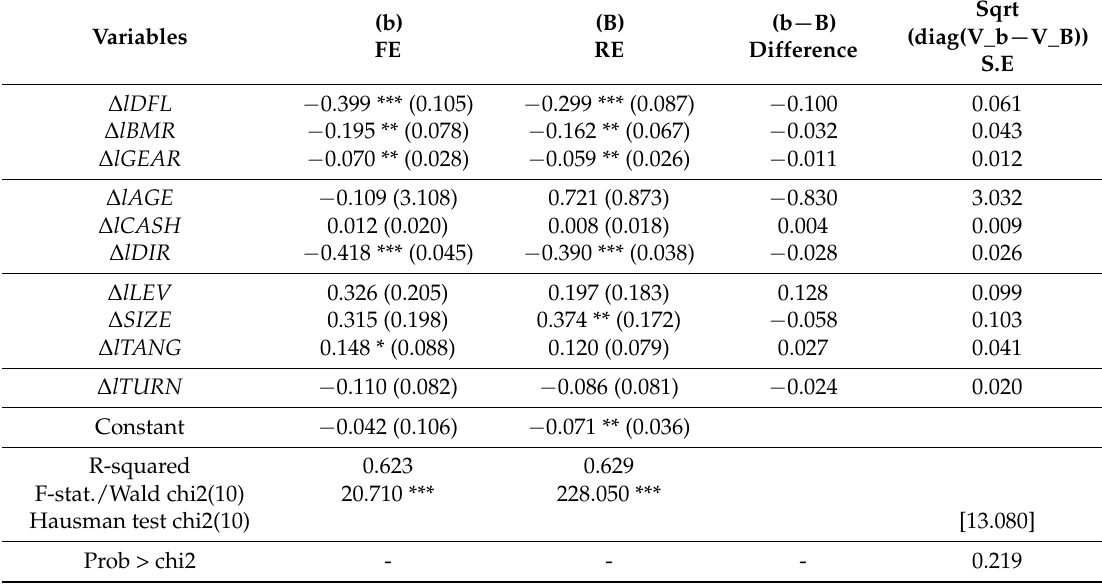
Table A5. Hausman test between the fixed effects model and the random effects model (Model 3).